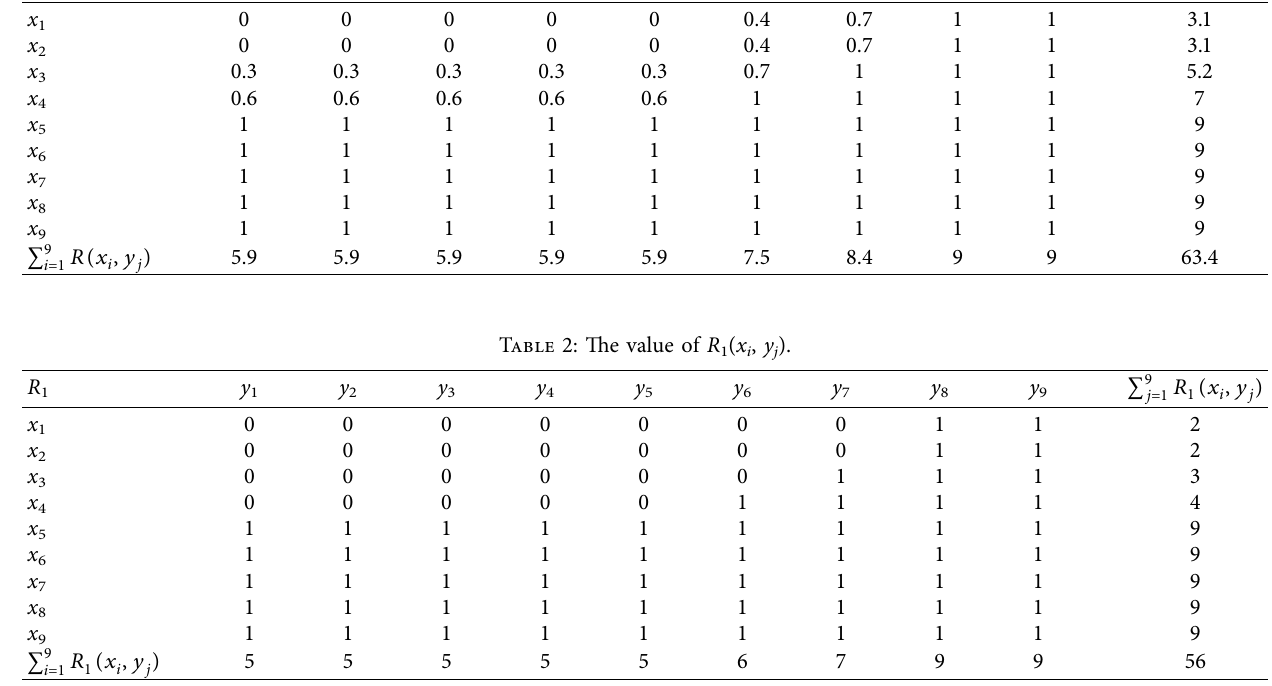
Table 1: The value of R ( x